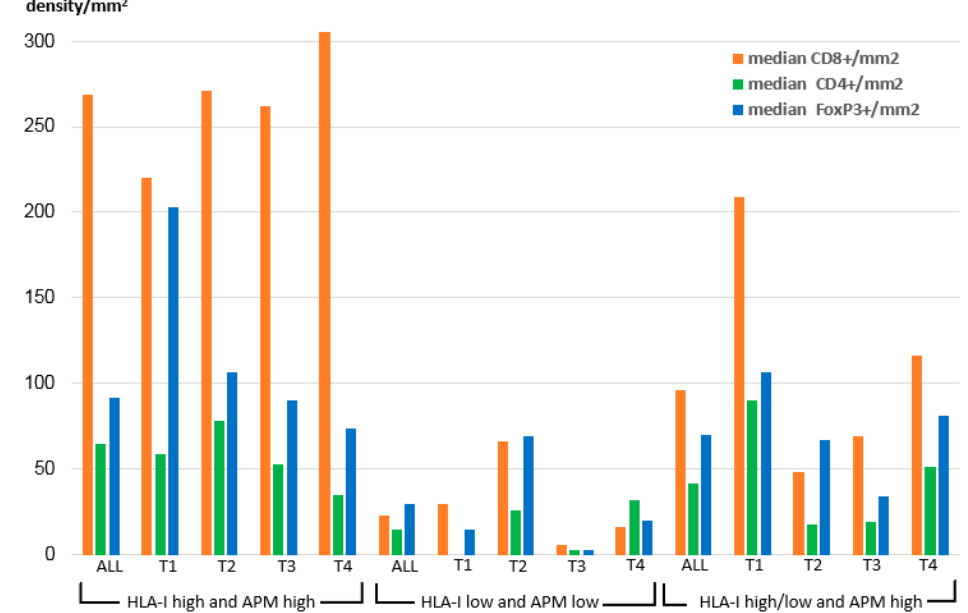
Figure 2. Intra-tumoral median density of T cell subpopulations across the HLA-I/APM phenotypes I-III in correlation to the T stage.